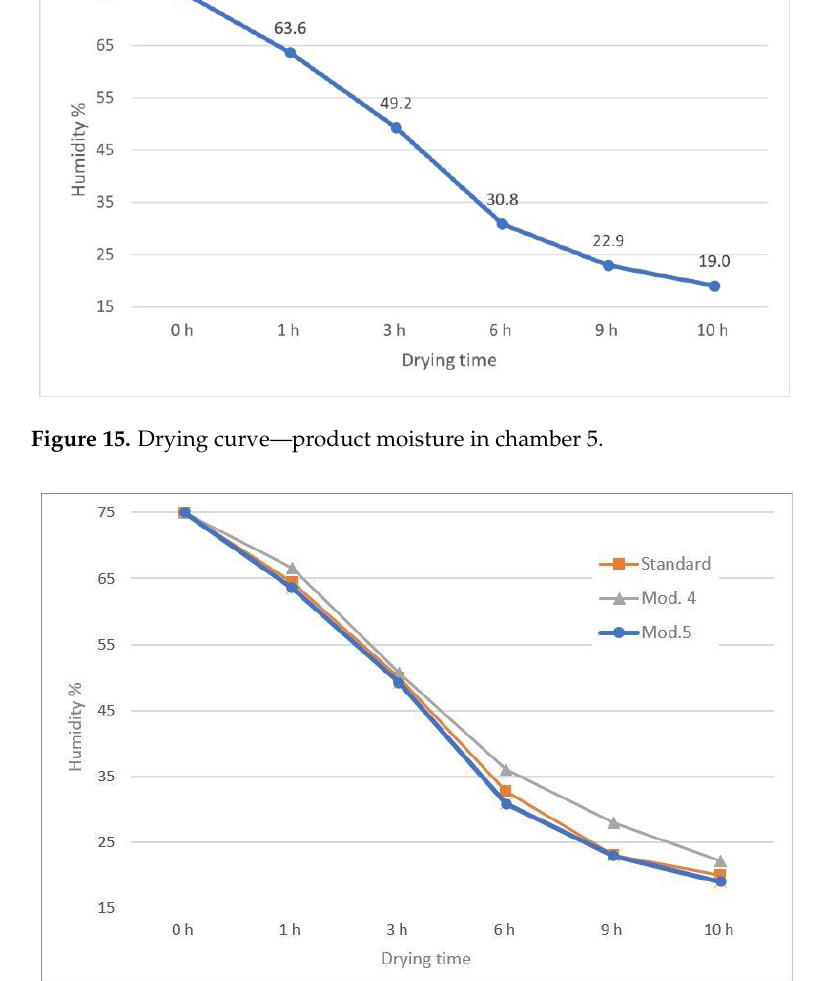
Figure 16. Drying curve—comparison of average product moisture in analyzed chambers.